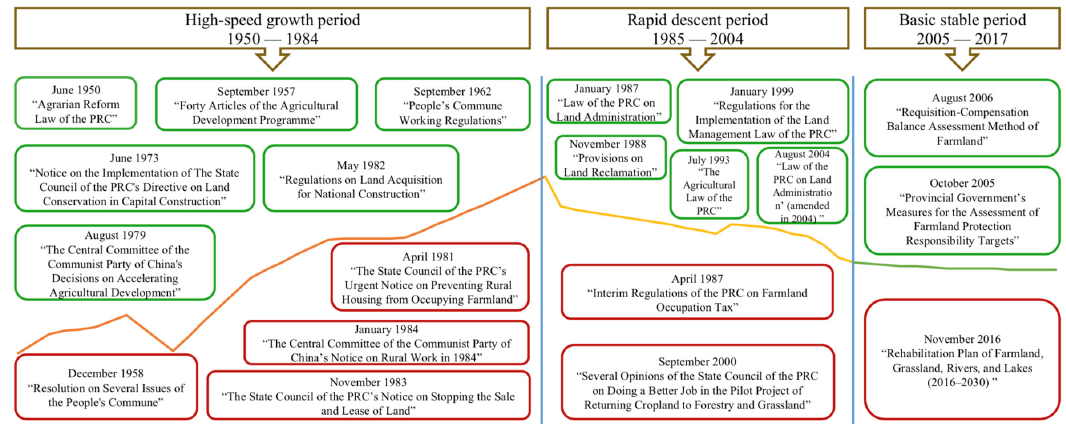
Figure 5. Changes in China’s farmland use policies; further details can be found in the Appendix A.